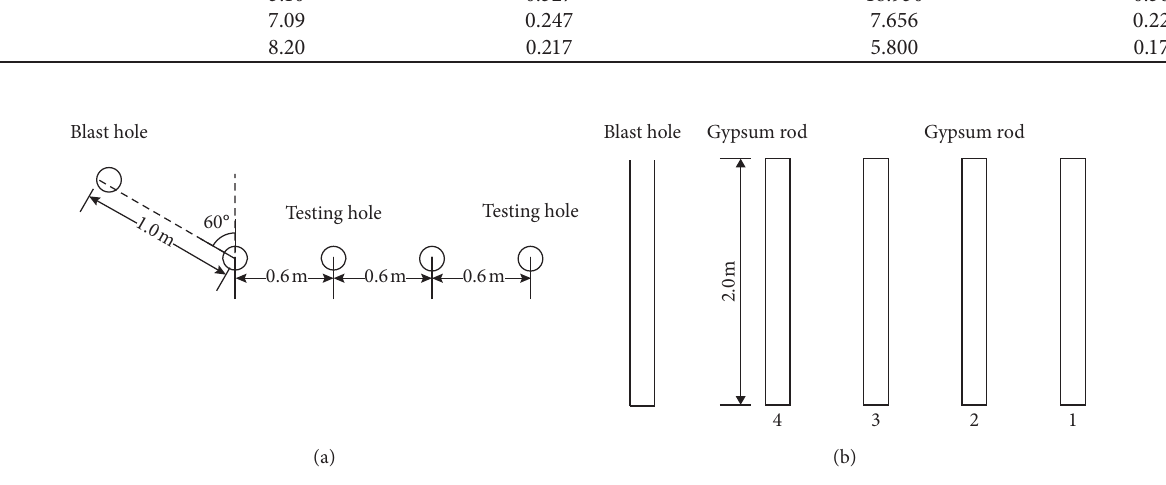
Figure 6: Schematic diagram of the field blasting test: (a) plan view; (b) sectional view.